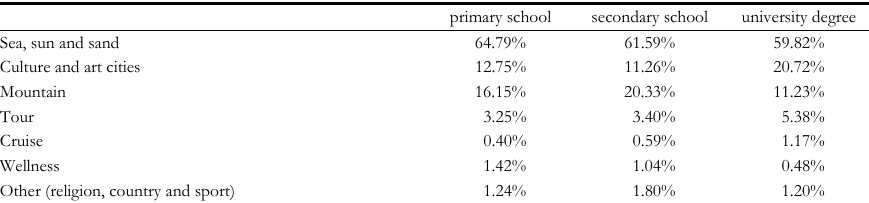
Holiday choices by schooling levels (world